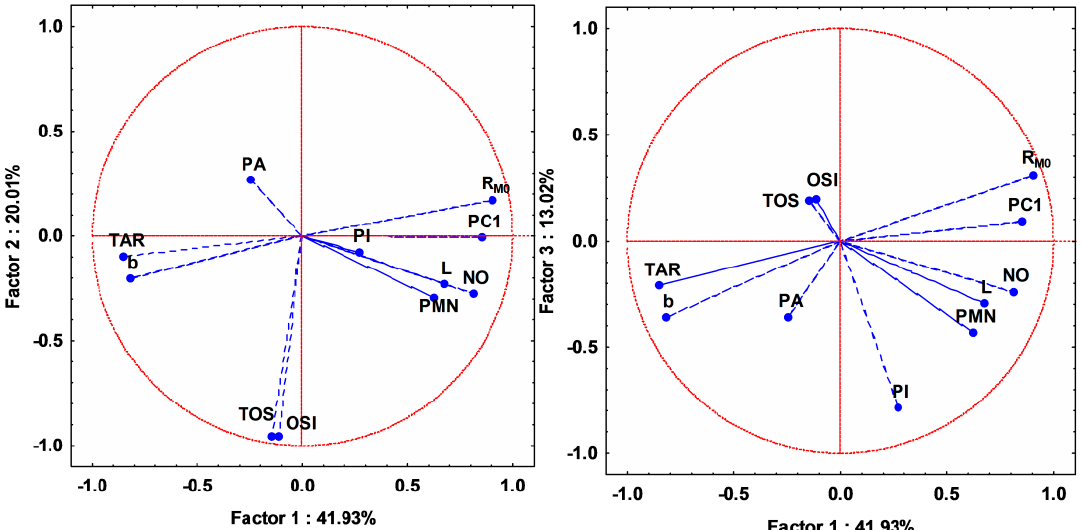
Figure 8. Loadings (circle correlation) for the assessed biological activity ( left panel ) and lipophilicity indices ( right panel ) for all studied compounds. L = leukocytes; PMN = polymorphonuclear leukocytes; PA = phagocytic activity; PI = phagocytosis index; NO = nitric oxide; TOS = total oxidative status; TAR = total antioxidant response; OSI = oxidative stress index; R M0 = lipophilicity estimation parameter; b = slope; PC1 = first principal component.